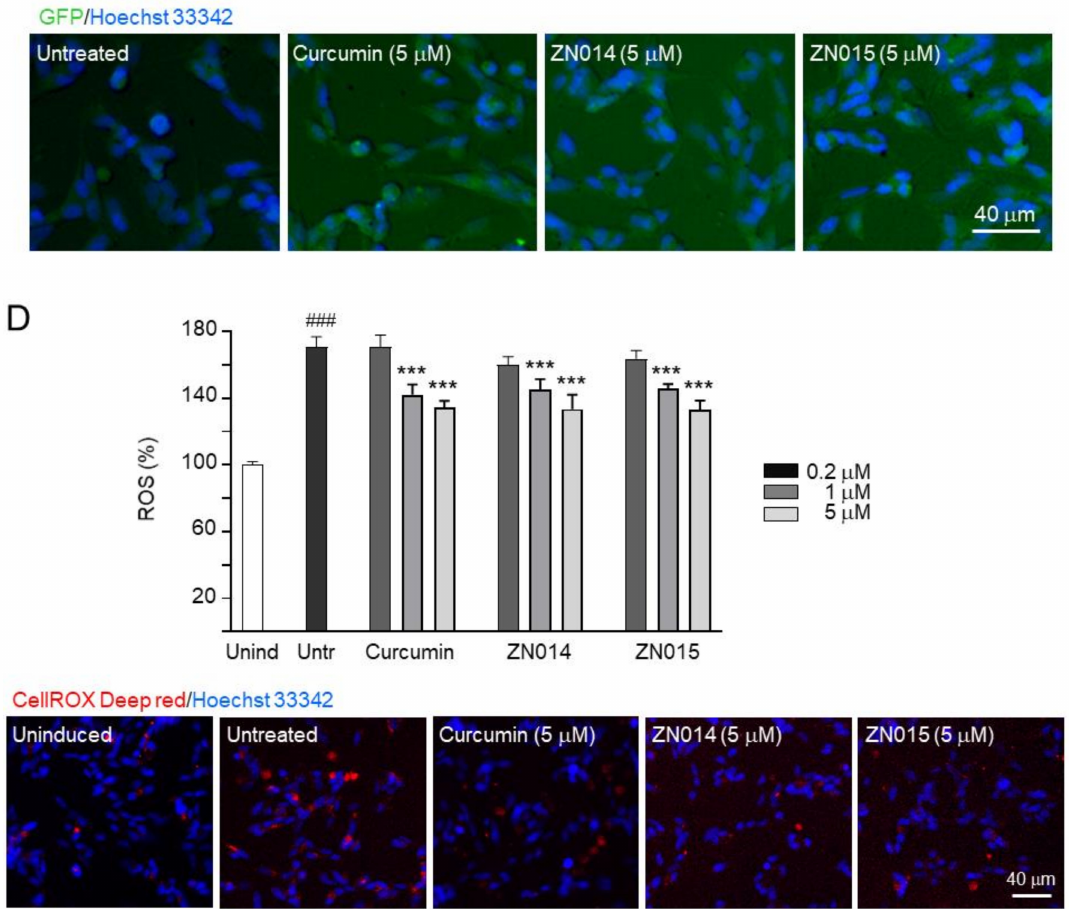
Figure 2. A β aggregation inhibition and ROS reduction of tested coumarins in SH-SY5Y cells expressing A β -GFP. ( A ) Experimental flow chart. Cells were plated with retinoic acid (RA, 10 µ M) addition on day 1 and treated with tested compounds (0.2–5 µ M) for 8 h, followed by inducing A β -GFP expression with doxycycline (Dox, 5 µ g/mL) on day 2. A β -GFP fluorescence, cell number, induced A β -GFP RNA, and ROS were measured on day 8. ( B ) Quantitation of GFP fluorescence and cell number in A β -GFP–expressing cells untreated or treated with curcumin, ZN009, ZN010, ZN011, ZN014, or ZN015 at 0.2–5 µ M ( n = 3). The relative GFP fluorescence and cell number of untreated cells were normalized as 100%. p- values: comparisons between with and without compound addition (*: p < 0.05, **: p < 0.01; two-tailed Student’s t -test). Shown on the bottom were GFP (green) images of A β -GFP–expressing cells untreated or treated with 5 µ M curcumin, ZN014, and ZN015. Nuclei were counterstained with Hoechst 33342 (blue). ( C ) Real-time PCR analysis of A β -GFP RNA in SH-SY5Y cells uninduced, untreated, or treated with 5 µ M curcumin, ZN014, or ZN015 ( n = 3). HPRT1 was used as an endogenous control to normalize between samples. ( D ) Quantitation of ROS ( n = 3), with relative ROS in uninduced cells normalized (100%). Shown at the bottom are images (CellROX Deep Red, red) of SH-SY5Y cells uninduced, untreated, or treated with the 5 µ M compound. Nuclei were counterstained with Hoechst 33342 (blue). ( C , D ) p -values: comparisons between untreated vs. uninduced cells ( ### : p < 0.001) or compound-treated vs. untreated cells (***: p < 0.001) (one-way ANOVA with a post hoc Tukey